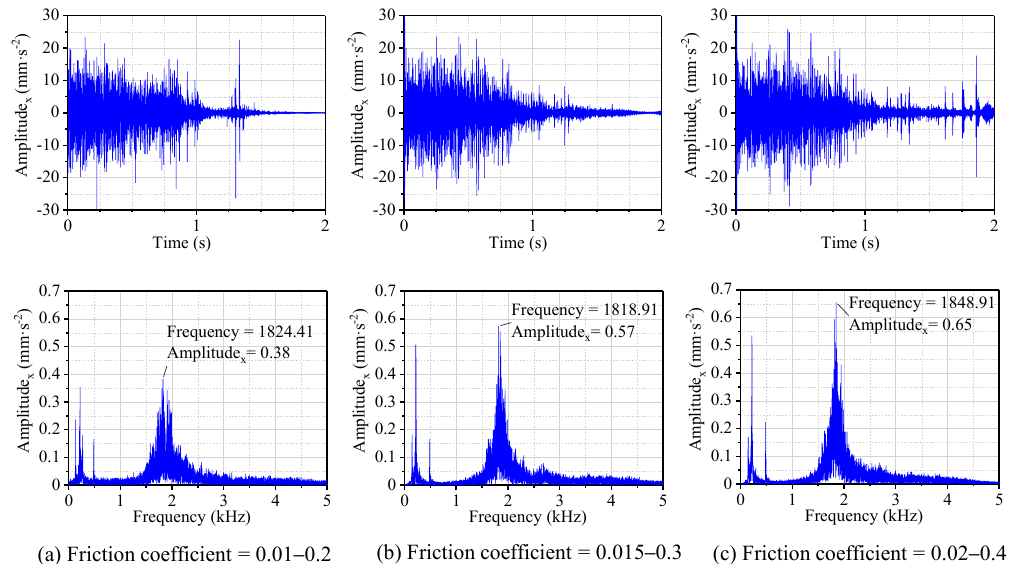
Figure 5. Displacement and frequency spectrum of N-502 with di ff erent friction coe ffi